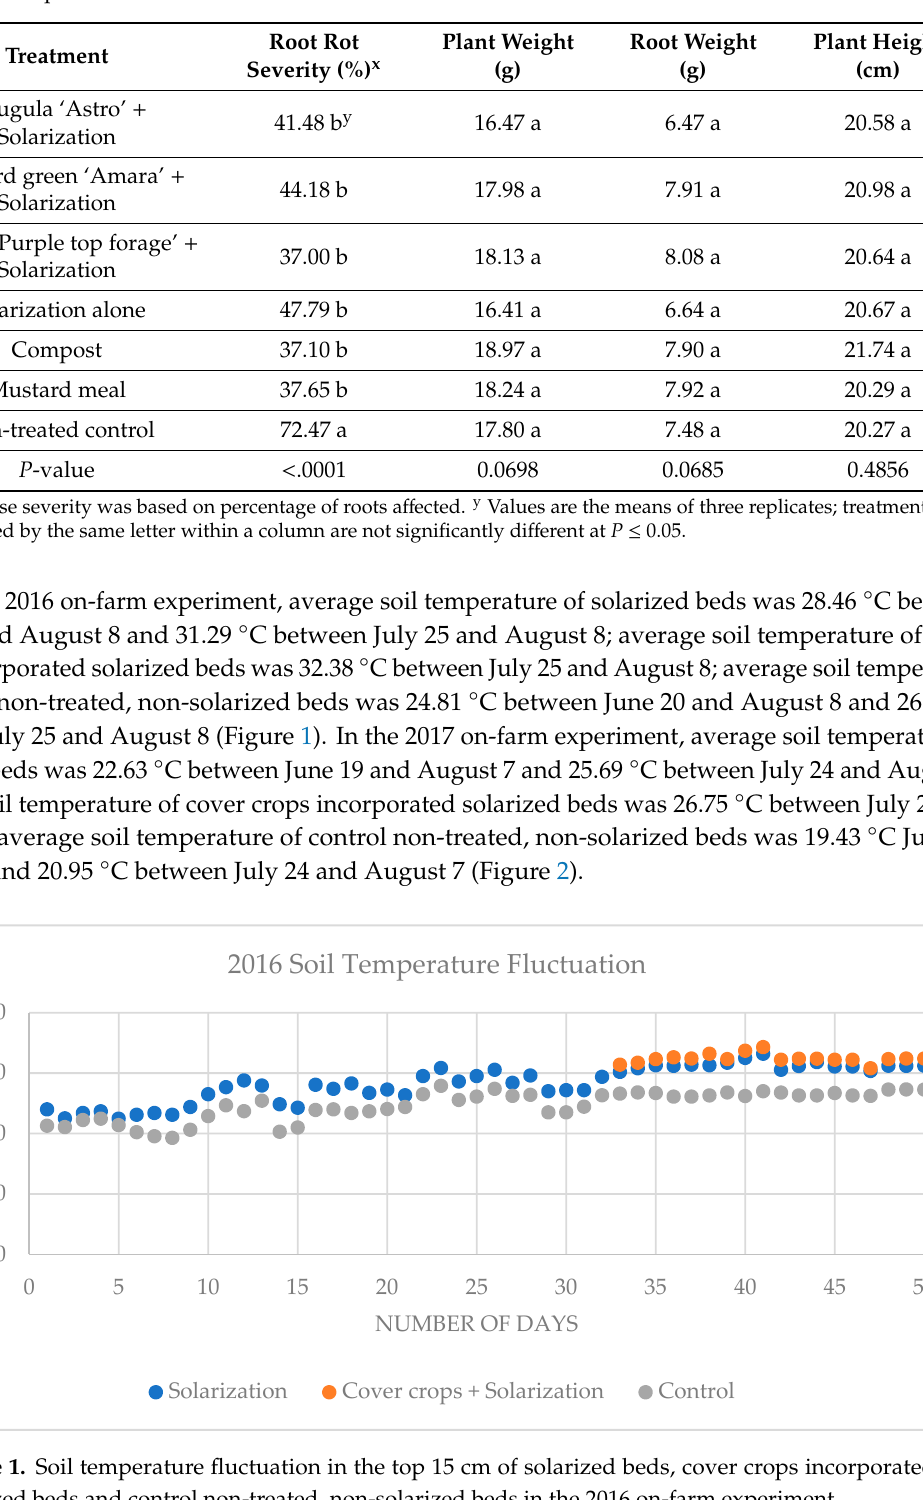
Table 2. Mean Rhizoctonia root rot severity and plant growth data of flowering cherry plants treated with solarization alone or in combination with cover crops, compost, and mustard meal, 2017 on-farm experiment.